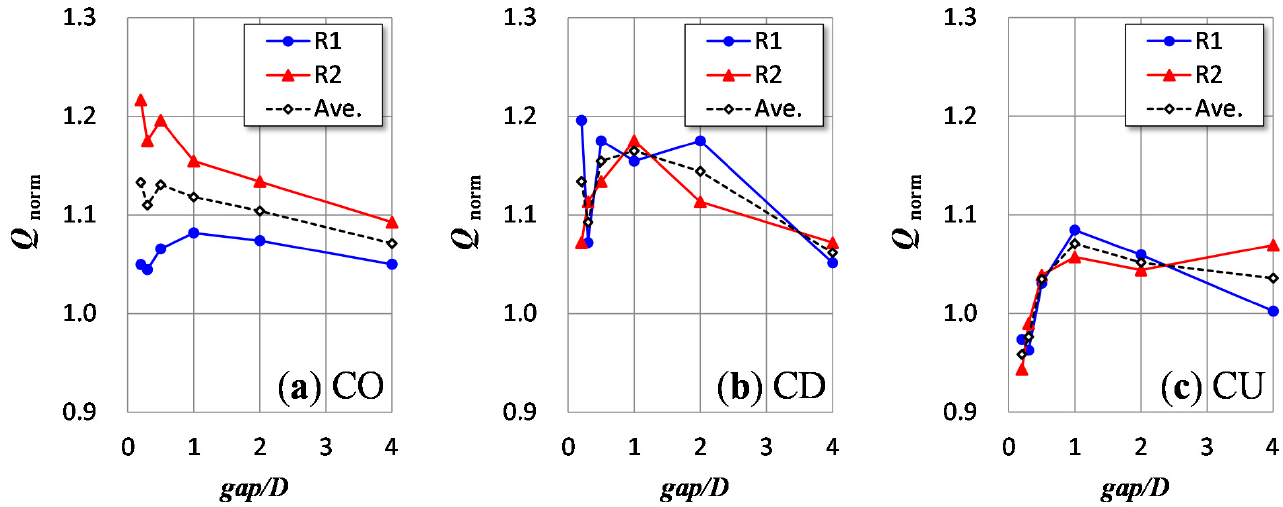
Figure 8. Gap dependence of normalized angular velocity of each rotor: ( a ) CO layout; ( b ) CD layout; ( c ) CU layout.